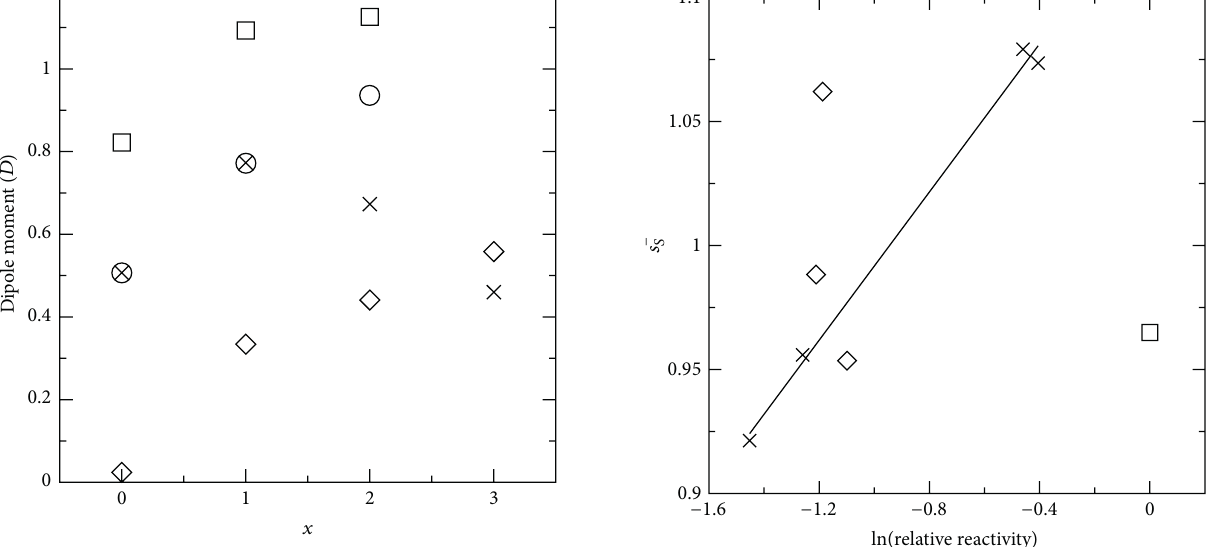
Figure 3: Absolute condensed atomic softness ( 𝑠 − ) versus natural S logarithm of the relative reactivity. Crosses represent the series of molecules {𝑥 ,4,7-TMDBT, (𝑥 = 1, 2,3)} and 4-MDBT, diamonds represent { 4,6-DMDBT, 1,4,6-TMDBT, and 2,4,6-TMDBT } , and the square represents the molecule 1,3,7-TMDBT. Relative reactivity represents experimental data from [3]. The line represents a linear regression of the plotted data for the